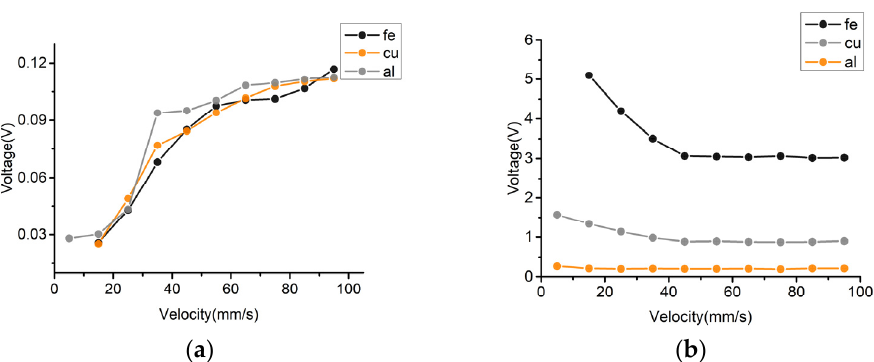
Figure 13. Diagram of signal variation with velocity: ( a ) Variation of metal particle voltage amplitude affected by velocity, ( b ) Variation of the total signal amplitude of the metal particles with varying velocity.